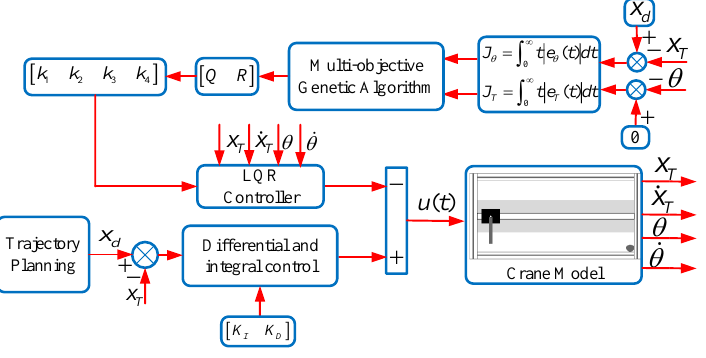
Figure 2. Flowchart of the controller design.